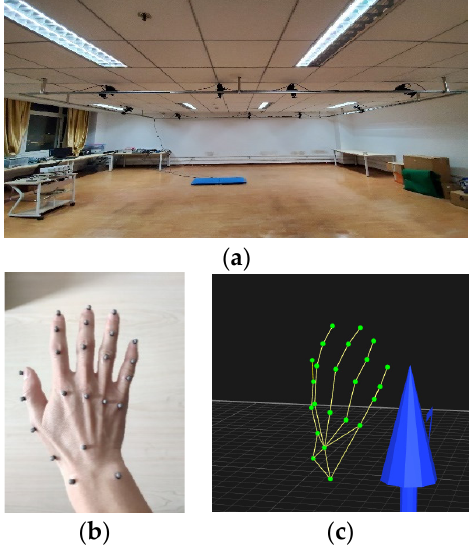
Figure 12. Motion capture system: ( a ) system setup, ( b ) distribution of the markers on hand joints and ( c ) hand models based on the markers.